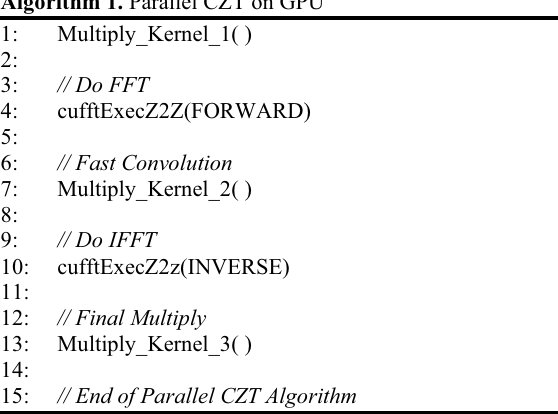
Algorithm 1. Parallel CZT on GPU